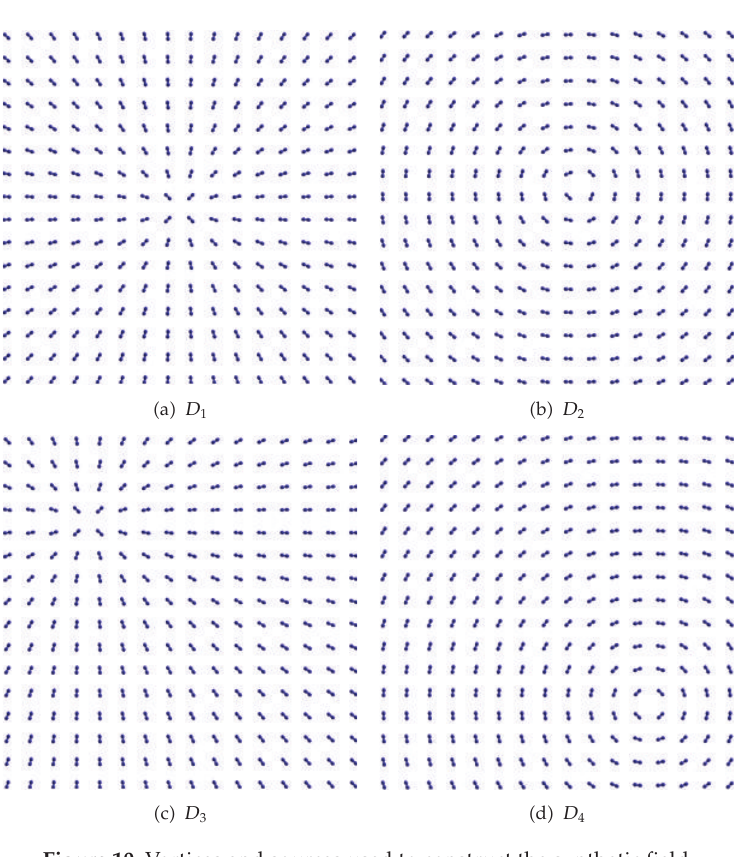
Figure 10: Vortices and sources used to construct the synthetic field.